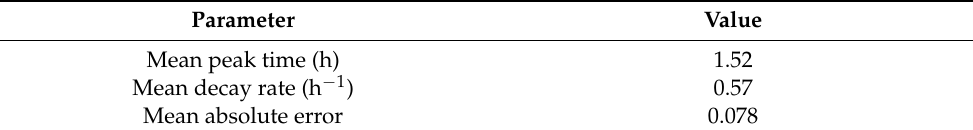
Table 3. Average results.